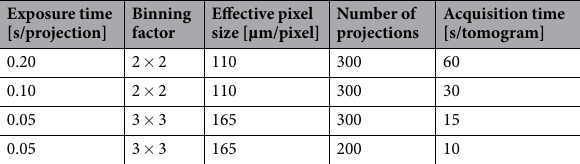
Table 2. Imaging parameter during initial test